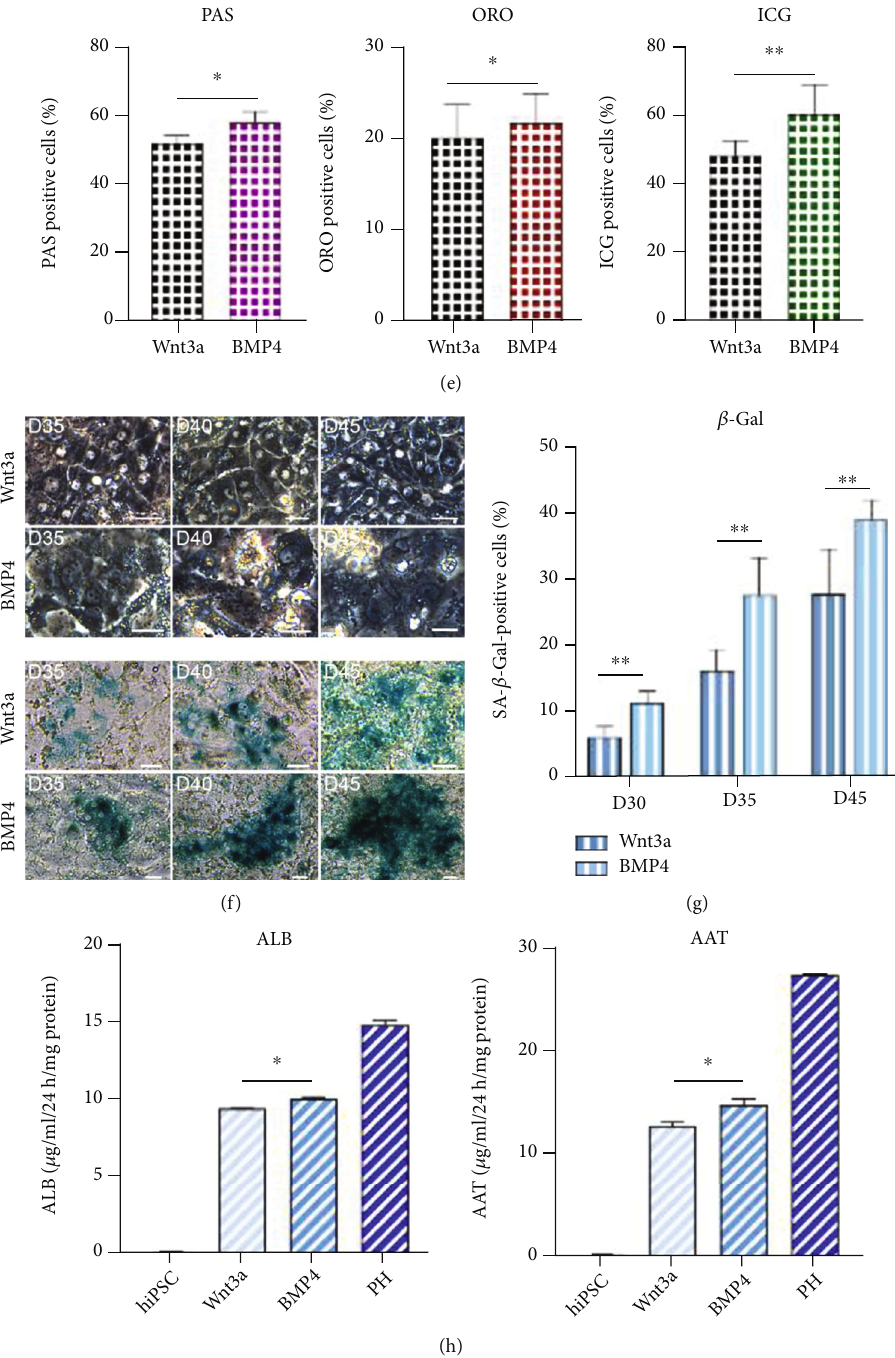
Figure 3: Hepatocyte functional assay after hepatocyte and nonparenchymal cell codi ff erentiation. (a) Quantitative PCR analysis showed the expression levels of mature hepatocyte markers. ∗ p < 0 : 05 , ∗∗ p < 0 : 01 , ∗∗∗ p < 0 : 001 , and n = 3 . (b, c) Immuno fl uorescence showed the coexpression of mature hepatocyte markers in day 25 cells. Scale bars, 50 μ m. ∗ p < 0 : 05 , ∗∗ p < 0 : 01 , ∗∗∗ p < 0 : 001 , and n = 3 . (d, e) Hepatocytes performed PAS staining (top), ORO staining (middle), and ICG uptake/release analysis (bottom). Scale bars, 25 μ m. ∗ p < 0 : 05 , ∗∗ p < 0 : 01 , ∗∗∗ p < 0 : 001 , and n = 3 . (f, g) Phase-contrast images of senescence β -Gal staining in hepatic cells during days 35-45 treated with Wnt3a or BMP4. Scale bars, 25 μ m. ∗ p < 0 : 05 , ∗∗ p < 0 : 01 , ∗∗∗ p < 0 : 001 , and n = 3 . (h) Production of ALB and AAT in day 35 hepatocytes. Primary hepatocytes were used as positive controls; hiPSCs were used as negative control. ∗ p < 0 : 05 , ∗∗ p < 0 : 01 , ∗∗∗ p < 0 : 001 , and n = 3